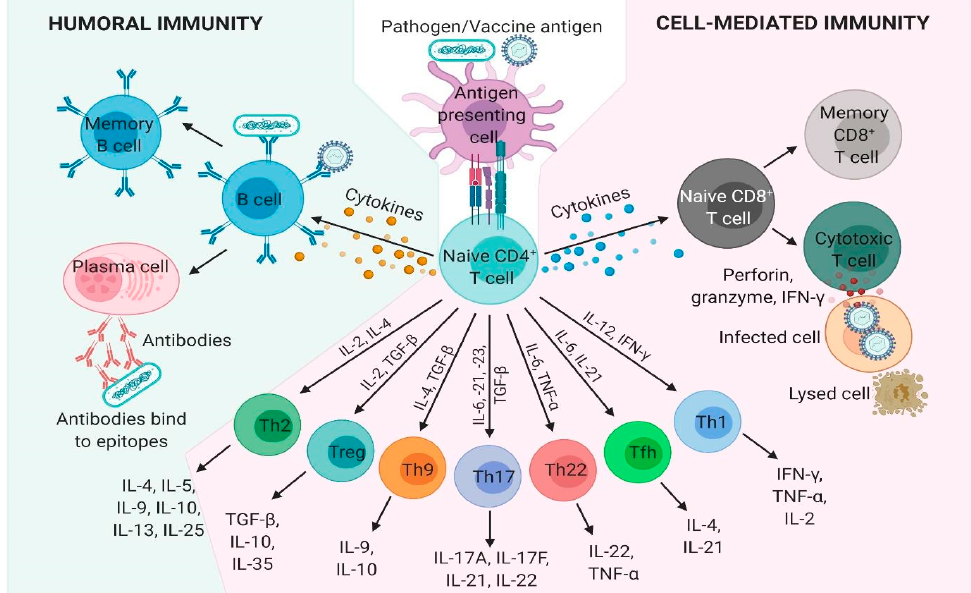
Figure 1. Humoral and cell-mediated adaptive immune responses. Adaptive immunity involves the activation of lymphocytes and develops following exposure to diseases or immunization against diseases through vaccination. Pathogen, tumor or vaccine antigens are recognized by antigen-presenting cells (APCs). Once processed, the antigenic peptides are presented on the surface of major histocompatibility complex (MHC)-II, which are recognized by T cell receptors (TCR) on naïve CD4 + T cells. Upon TCR activation by APCs, naïve CD4 + T cells differentiate into subpopulations: T helper (Th)1, Th2, Th9, Th17, Th22, T follicular helper (Tfh), and T regulatory cells (Treg) under unique cytokine-polarized environments. B-cells, following co-stimulation from cytokines produced by CD4 + T cells, transform into plasma cells that secrete antibodies which circulate in blood and extracellular fluid. A humoral immune response is mediated by secreted antibodies produced by B-cells, which are specific for an individual antigen. CD8 + T cells recognize and bind to intracellularly processed antigenic peptides through their TCR, which are presented on MHC-I molecules on the surface of APCs and infected cells. Cytokines released by CD4 + T cells also stimulate cytotoxic CD8 + T cells, which release effector molecules such as granzyme, perforin, and IFN- γ that destroy infected host cell. A subset of memory B and T cells confer future immunity to the cognate pathogen or antigen. IFN- γ , interferon gamma; IL, interleukin; TGF- β , transforming growth factor β ; TNF- α , tumor necrosis factor α .